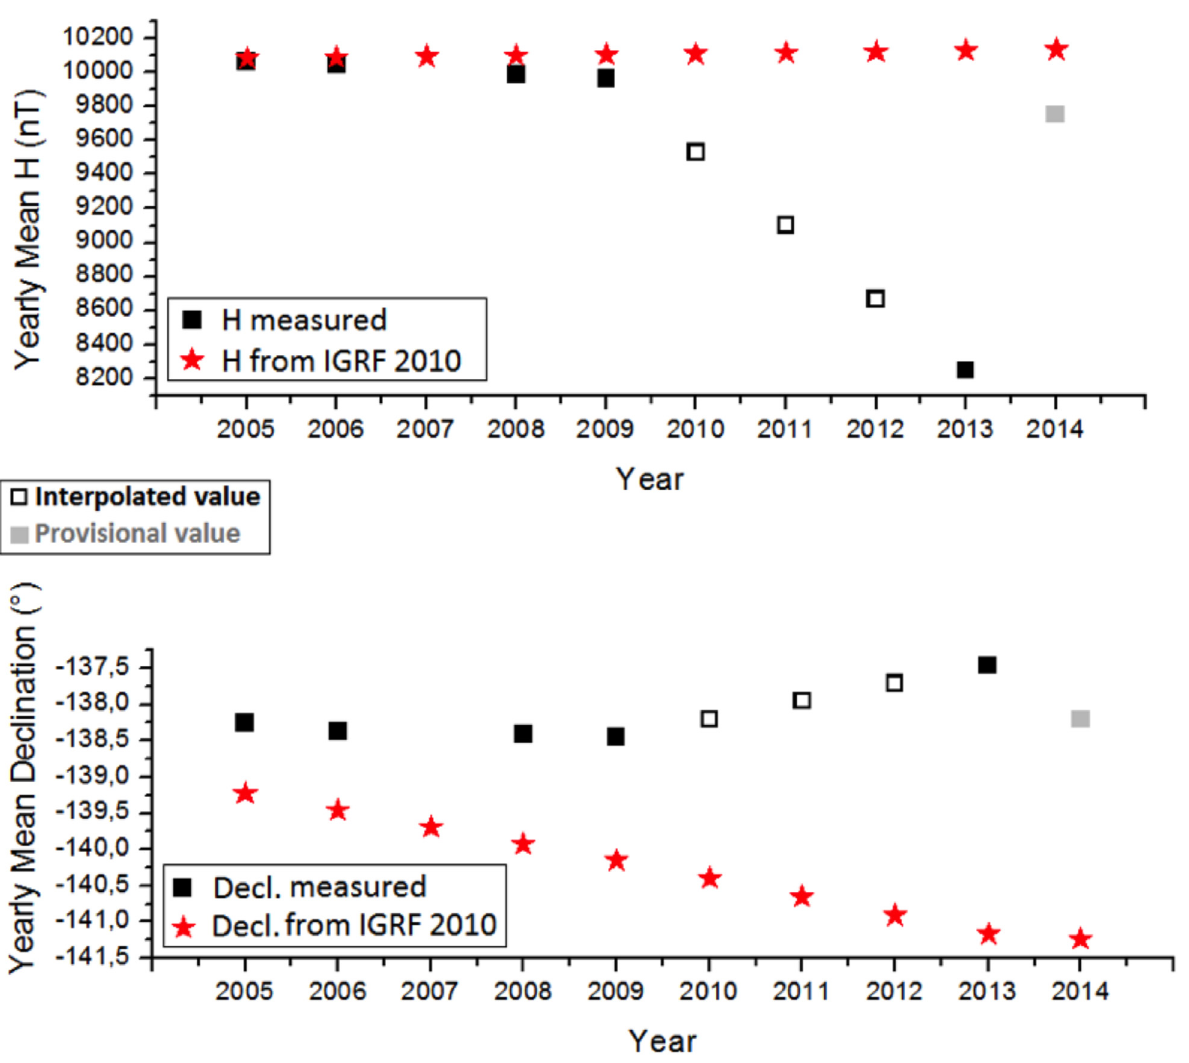
Figure 1. Comparison between the Horizontal component (top) and Declination (bottom) of the geomagnetic field from absolute measure- ments and from IGRF [2010] at the Concordia observatory. Values from 2010 to 2012 are linearly interpolated since observed values are under processing. Values for 2014 are provisional. Note the progressive divergence from the initial years and the inverse trend between 2013 and 2014 for both graphs. This latter trend needs to be confirmed in the future years. However, it is also important to note that in polar regions the com- parison of measured geomagnetic values with those from the IGRF model is known to be somehow weak [De Santis A. et al.